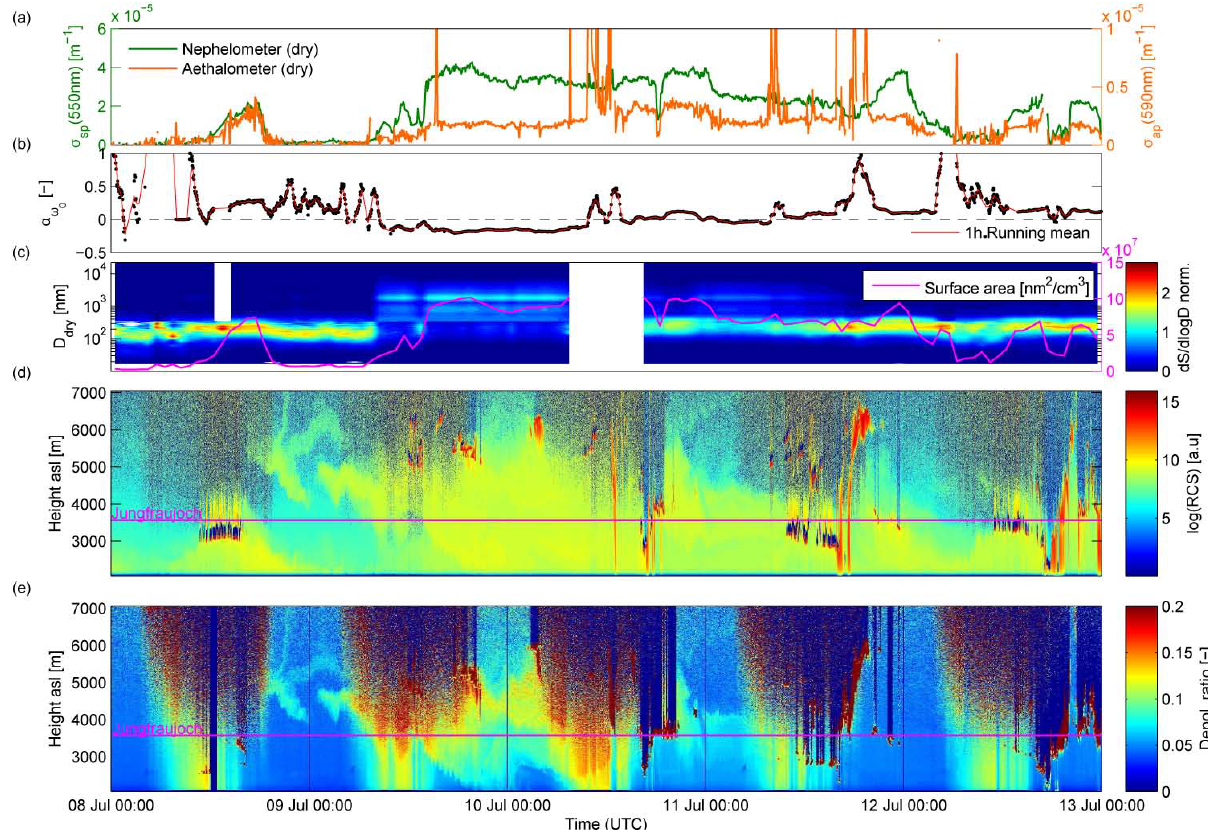
Fig. 7. A strong Saharan dust event was observed by different in-situ and remote sensing instruments. (a–c) are in-situ measurements at the Jungfraujoch station. (a) Dry scattering (green line) and absorption coefficient (orange line); (b) the ˚Angstr¨om exponent of the single scattering albedo (Saharan dust index); (c) normalized surface size distribution measured by the SMPS and OPC (see color code), the mean surface area is shown as well (magenta line); (d) range corrected signal (RCS) of the ceilometer; (e) depolarization ratio measured by the LIDAR. Ceilometer and LIDAR measured from the Kleine Scheidegg. Horizontal magenta line: altitude of the Jungfraujoch at 3580m